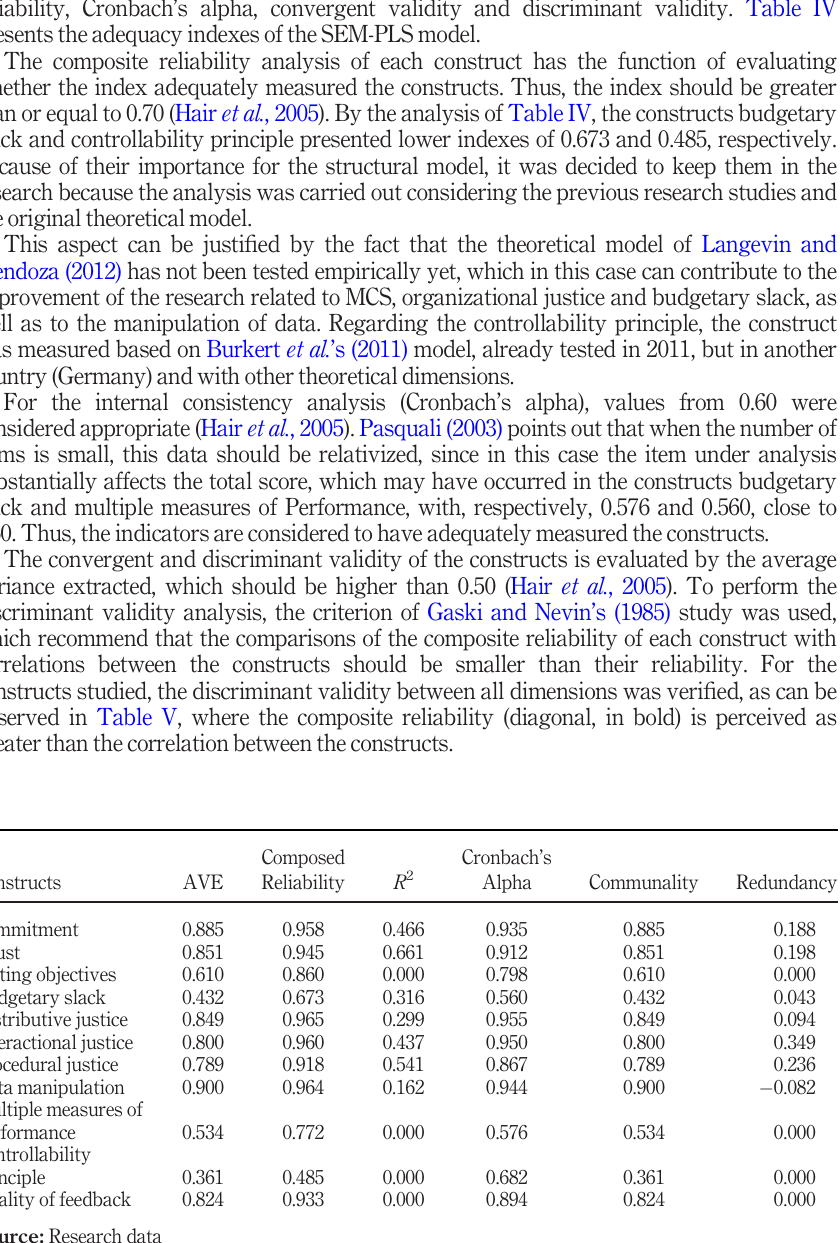
Table IV. Adequacy indexes